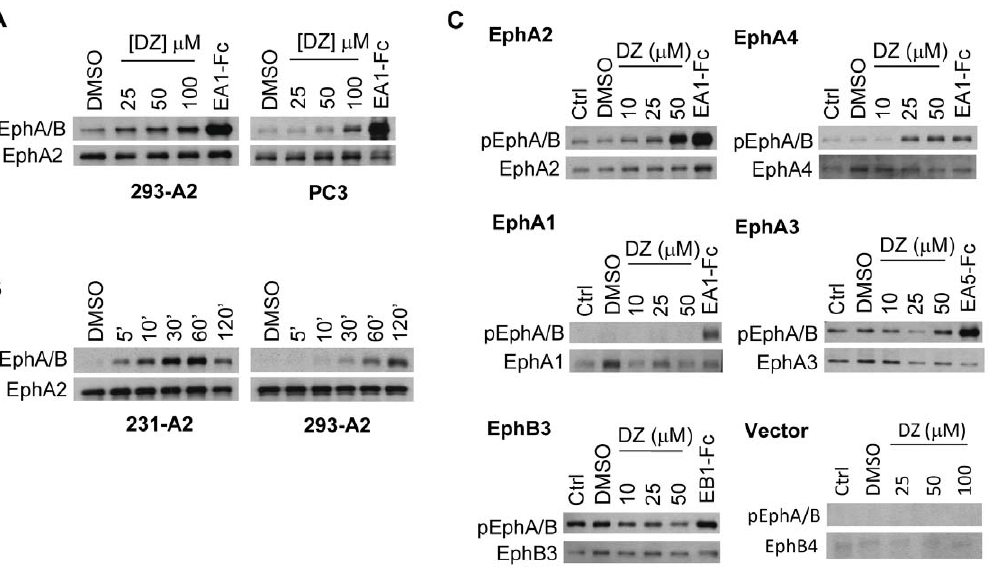
Figure 2. Doxazosin activates EphA2 receptor in different cell types. (A) Immunoblots for pEphA/B on lysates from PC-3 and HEK 293-A2 (293-A2) cell lines treated for 30 minutes with indicated doses of doxazosin (DZ). (B) Immunoblots for pEphA/B on lysates from MDA-231-A2 (231-A2) and 293-A2 cell lines treated with 50 m M DZ in 0.2% DMSO for indicated times. (C) Doxazosin selectively activates EphA2 and EphA4 receptors. Immunoblots for pEphA/B on lysates from HEK 293 cell lines expressing given Eph receptors following treatment with indicated doses of doxazosin (DZ) for 60 minutes. Treatment with 1 m g/ml ephrin-A1-Fc ligand (EA1-Fc) for 10 minutes (EphA2) and 30 minutes (Vector, EphA1, EphA4), as well as 30 minute treatment with ephrin-A5-Fc (EA5-Fc) (EphA3) and ephrin-B1-Fc (EB1-Fc) (EphB3) served as positive controls. Blotting for total Eph kinases served as loading controls.